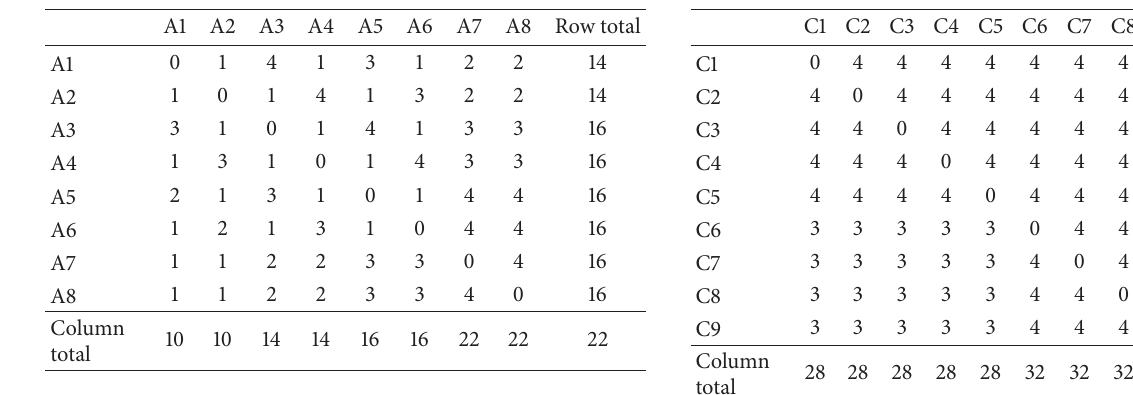
Table 6: The average matrix of model 1.